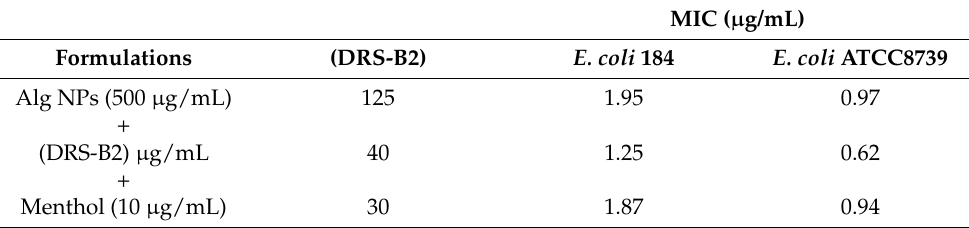
Table 4. MICs of the new formulation Alg NPs + DRS-B2 supplemented with menthol.